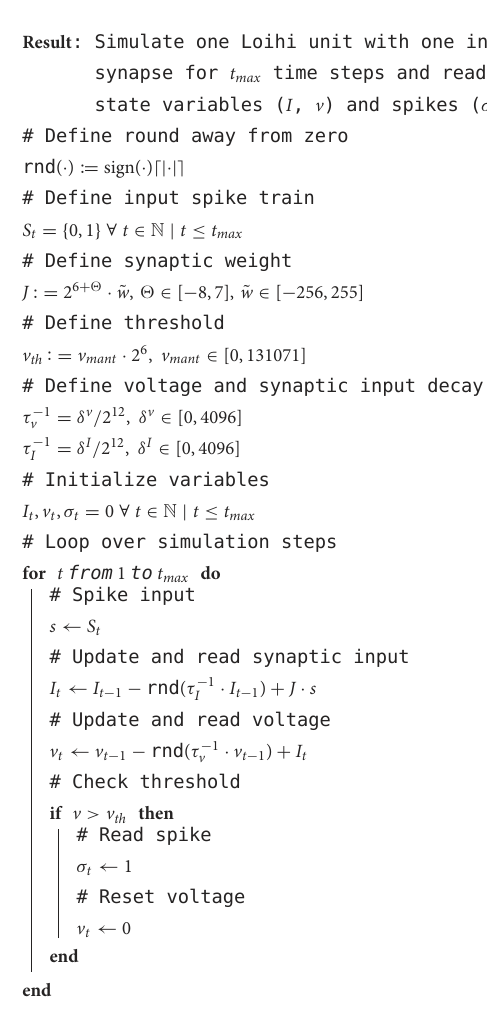
Algorithm 1. Loihi single neuron